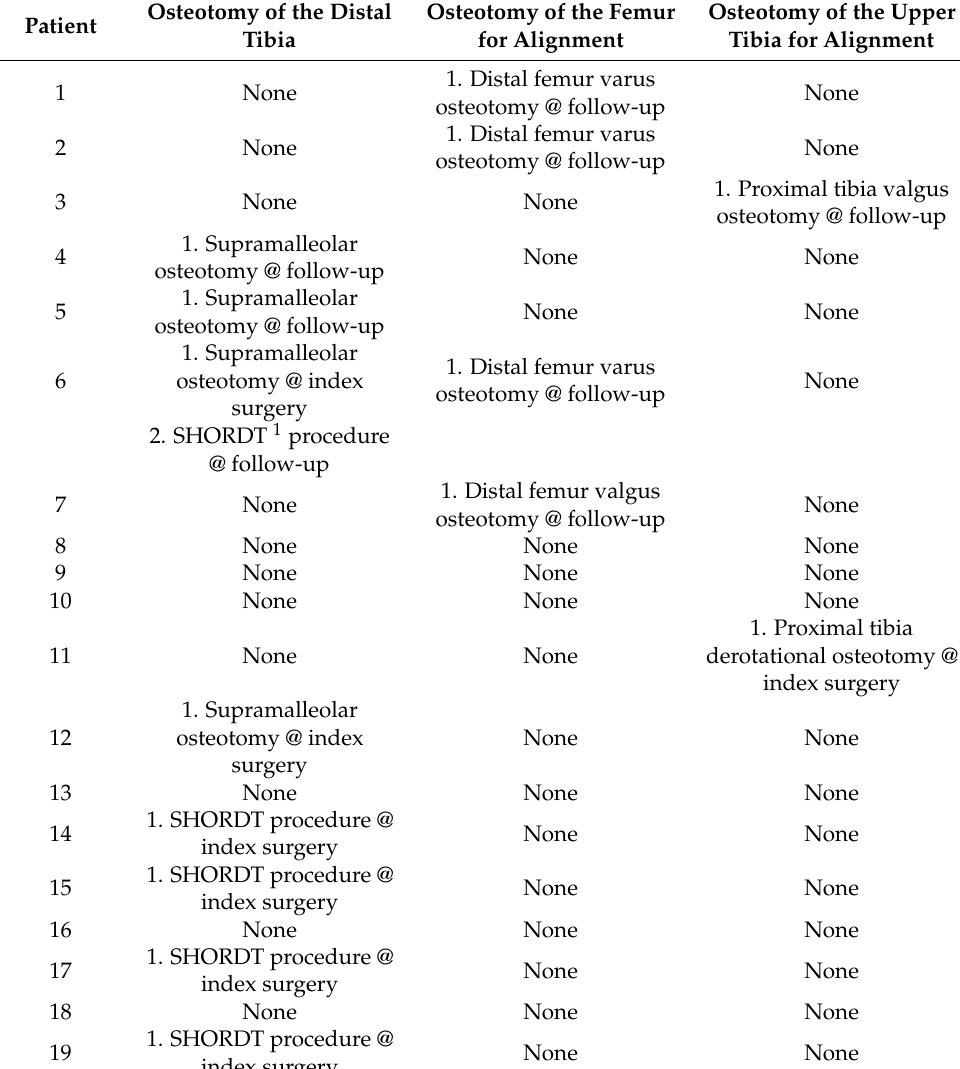
Osteotomy of the